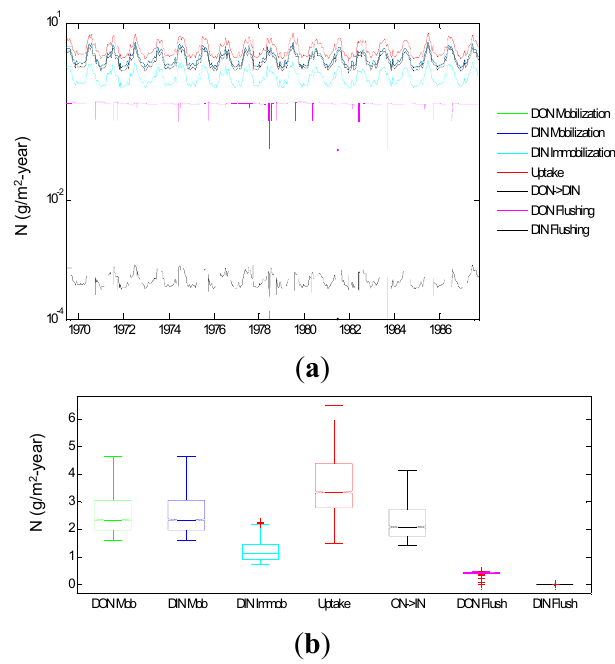
Figure 8. Key modeled rate terms associated with root zone SOM. ( a ) The plot represents the modeled time series, as indicated in the legend, across the 20 year simulation time frame. These data are summarized and presented as a box and whisker plot ( b ). Note that the y axis is log transformed in the upper plot, but is linear in the lower plot.